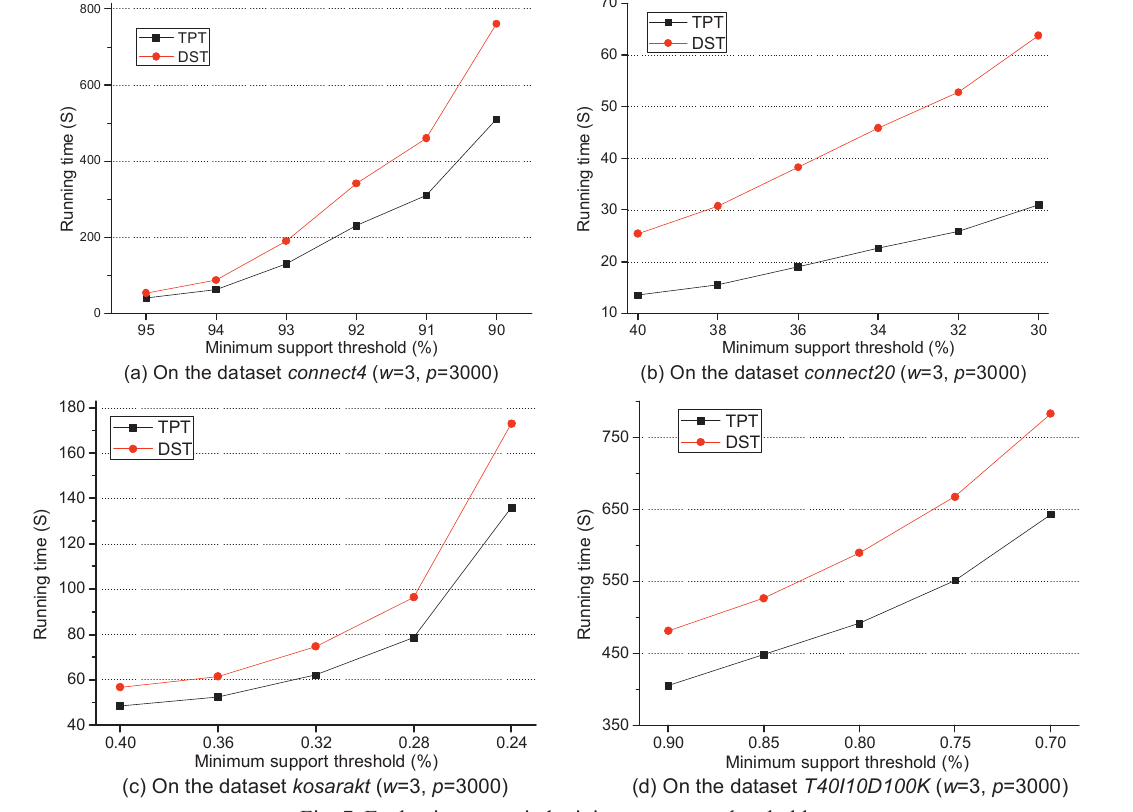
Fig. 7. Evaluation on varied minimum support